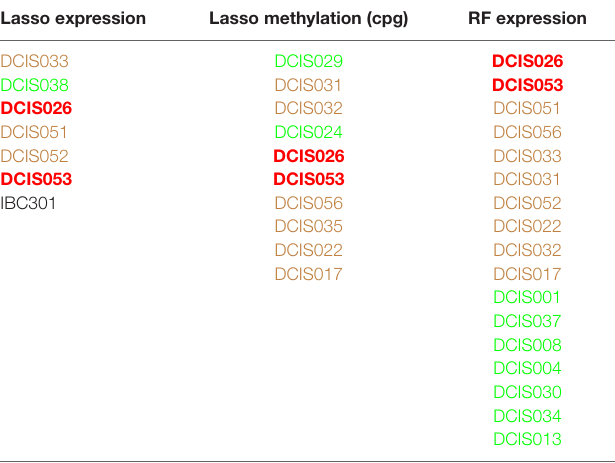
TABLE 1 | Misclassified training samples when using various classification models and omics data. Lasso expression Lasso methylation